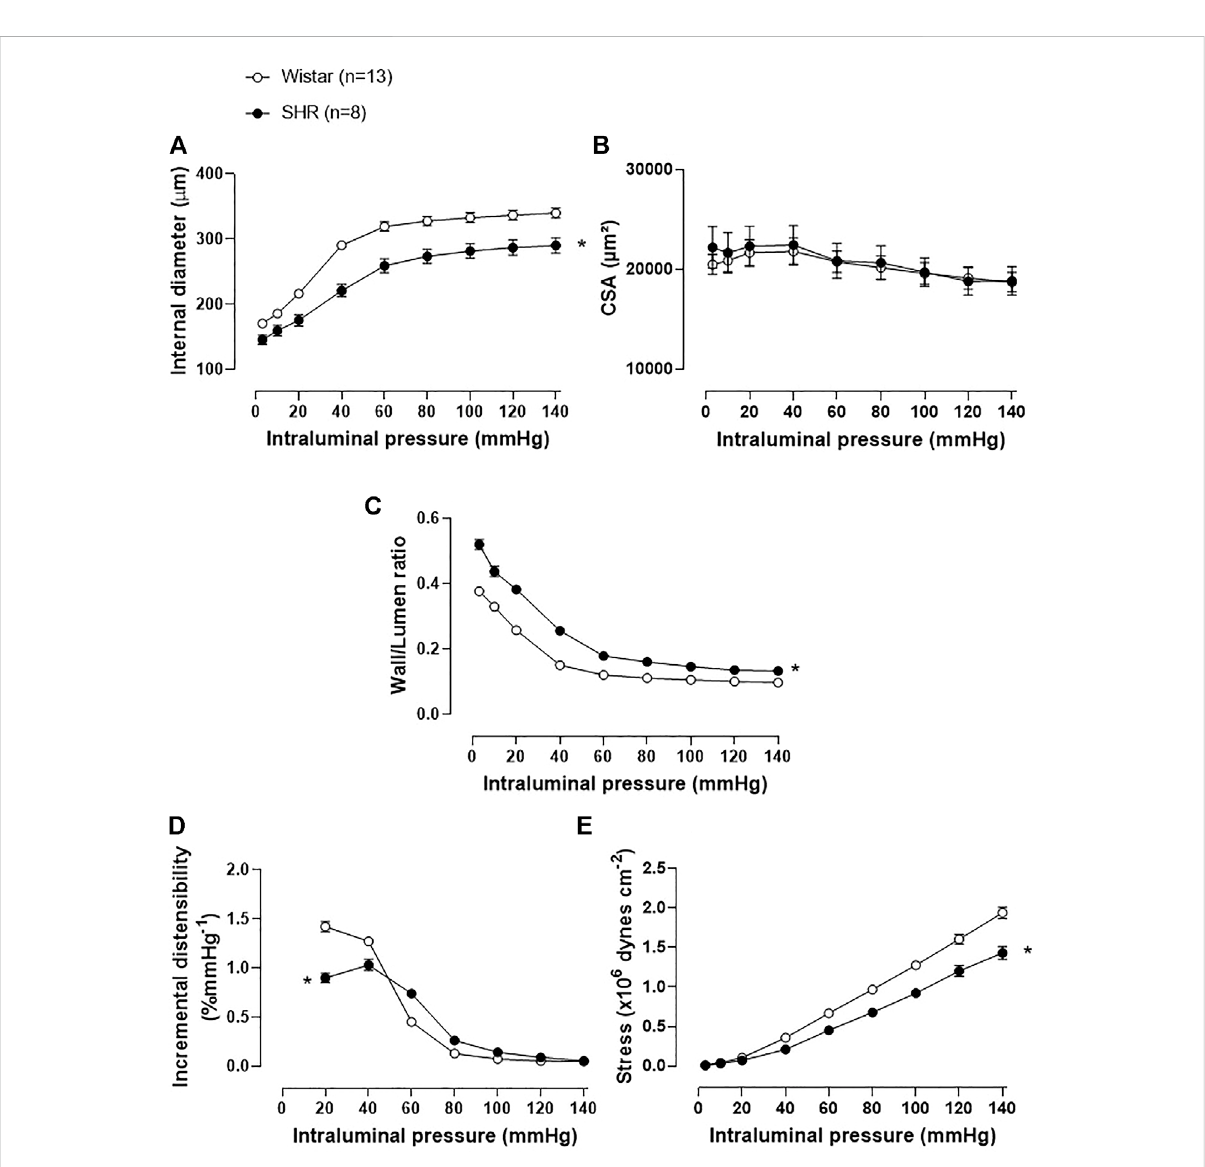
FIGURE 3 Structural and mechanical vascular remodeling on mesenteric resistance arteries of SHR. Comparison of the structural parameters: (A) internal diameter, (B) cross-section area (CSA), (C) wall/lumen ratio; and the mechanical parameters: (D) incremental distensibility and (E) stress of MRAs from adult Wistar and SHR. Analyses were obtained with a pressure myograph. The number of animals used in each experiment (n) is in parentheses. The results are expressed as the mean ± SEM and the statistical analysis was assessed by two-way ANOVA: * p < 0.05 vs